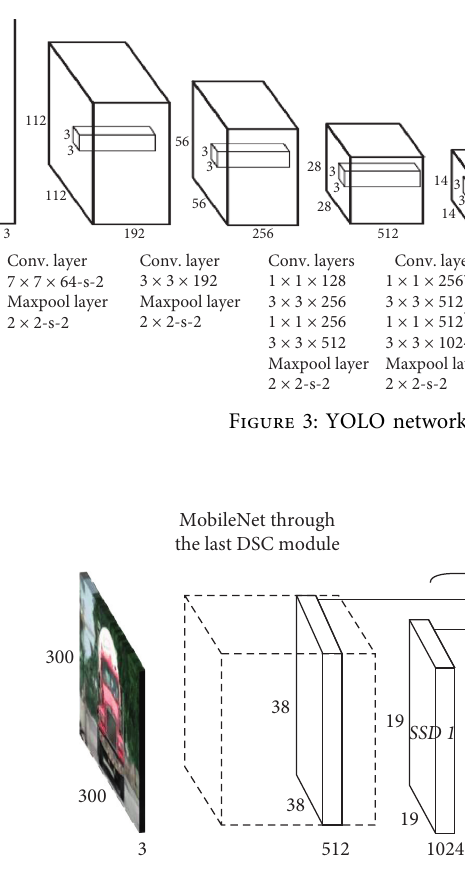
Figure 4: MobileNet-SSD network architecture (from